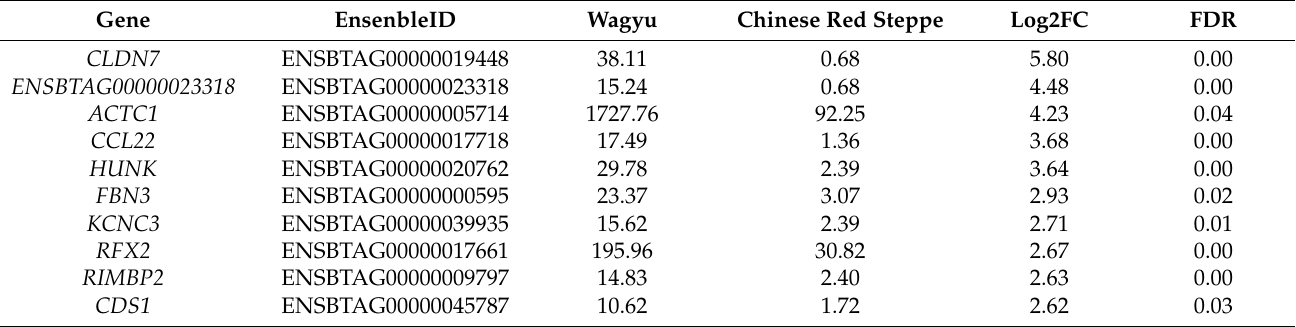
Table 1. The top 10 up-regulated DEGs in Longissimus dorsi in Wagyu and Chinese Red Steppe